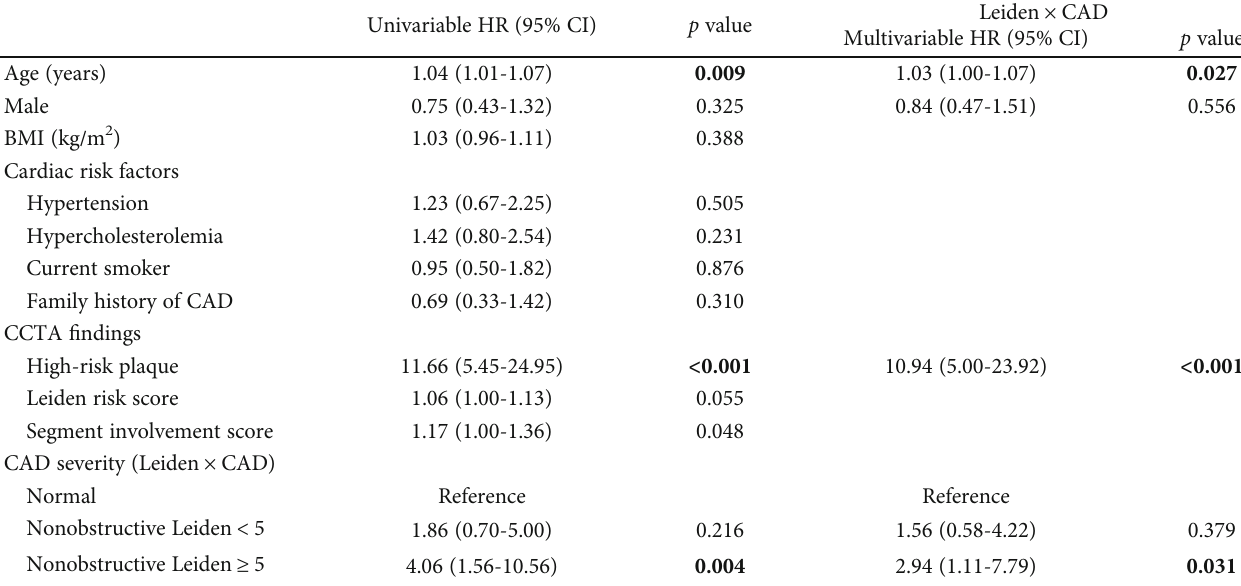
Table 2: Univariate and multivariate analyses of clinical pro fi le and CCTA fi ndings for major cardiovascular events.